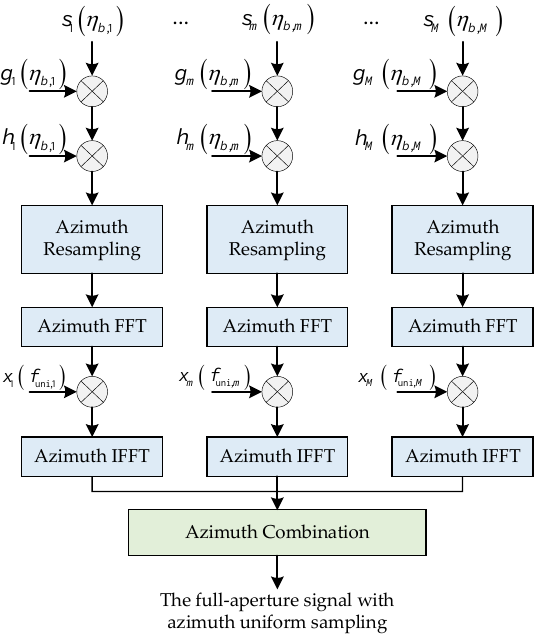
Figure 11. The block diagram of 1-D azimuth pre-processing of the proposed method. To eliminate the range walk term caused by the first term about azimuth time in (20), the phase compensation function g m ( η b , m ) in the m -th data block is multiplied